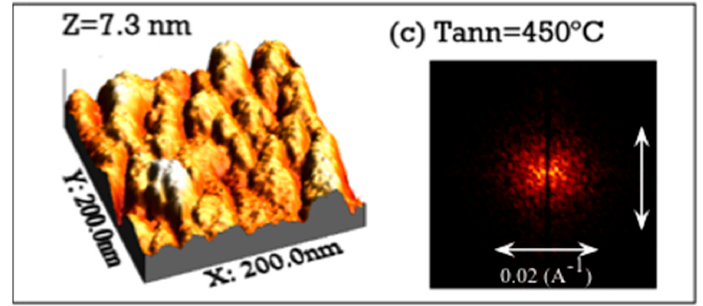
Figure 4. STM micrographs and 2D-FFT images of the obliquely deposited Co samples: ( a ) as-deposited; ( b ) 270 °C annealed and ( c ) 450 °C annealed.